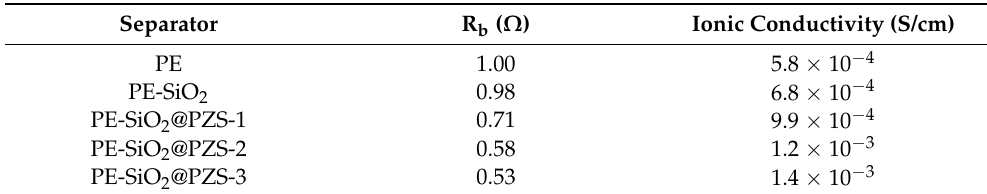
Table 3. R b and ionic conductivity of the PE membrane, PE-SiO 2 , PE-SiO 2 @PZS−1, PE-SiO 2 @PZS−2 and PE-SiO 2 @PZS−3 separators.